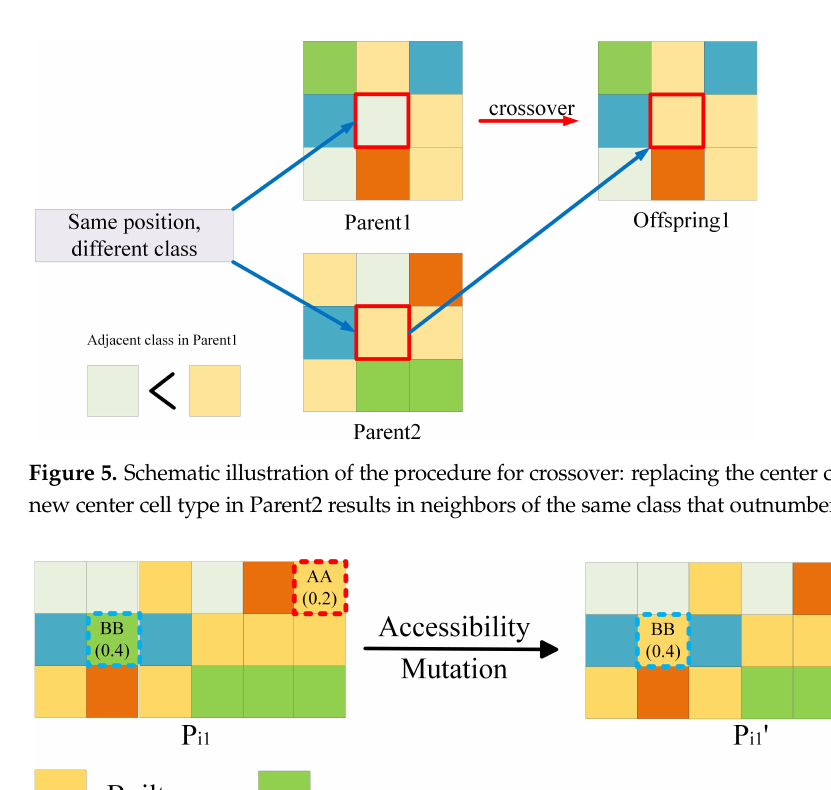
Figure 6. Procedure of mutation, where the selected cell in the parent is changed according to the accessibility value.